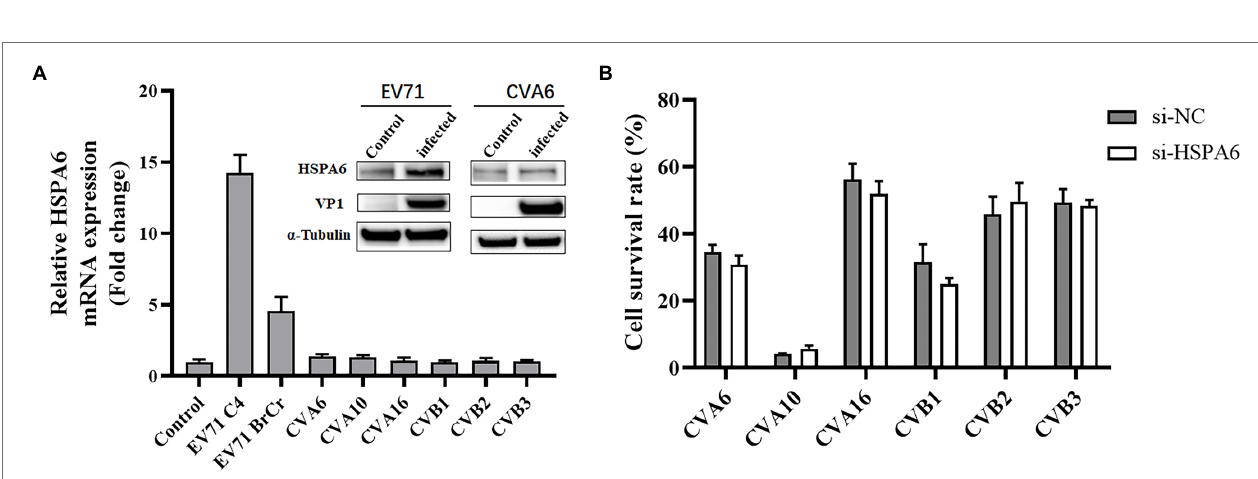
FIGURE 6 | HSPA6 is involved in the infection of EV71 but not other HFMD-associated viruses. (A) RT-PCR and Western blotting analysis of HSPA6 expression in RD cells infected with various HFMD viruses. RD cells were infected with 0.2 MOI of EV71 C4 strain, EV71 BrCr strain, CVA6, and CVA10, while Vero cells were infected with 1MOI of CVA16 and CVB1-3. After 8 h infection, the cells were subjected to RT-PCR analysis. Western blotting was also performed to analyze the expression of HSPA6 protein in RD cells infected with 0.2 MOI of EV71 or CVA6 at 36 hpi. (B) Survival analysis of RD cells transfected with siRNA targeting HSPA6 and infected with various viruses. RD cells or Vero cells were transfected with 100 nM of si-HSPA6 or si-NC for 24 h and then infected with the viruses for 72 h, followed by the cell survival detection with Alamar blue reagent.